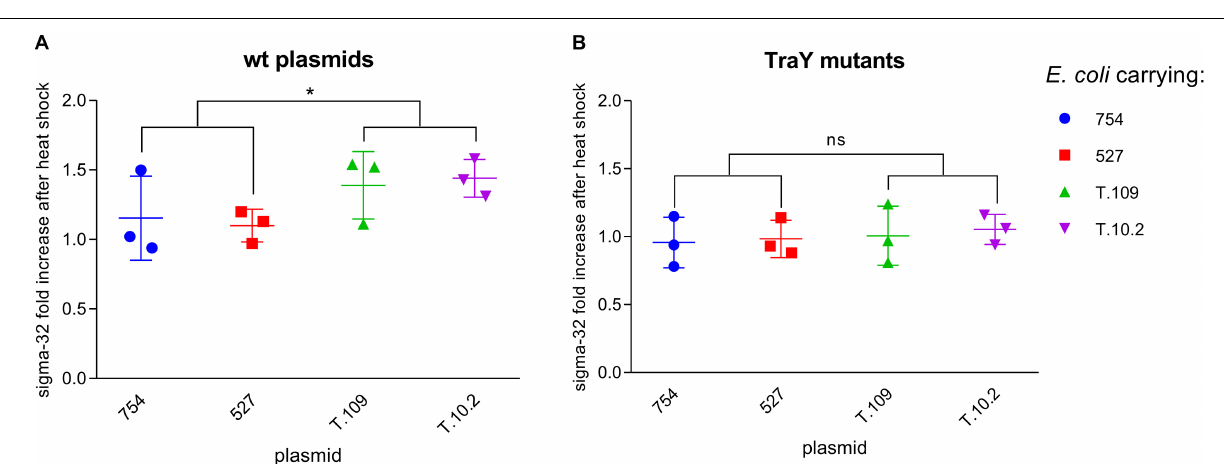
FIGURE 4 | (A) σ -32 fold increase between 37 and 42 ◦ C in Escherichia coli carrying wt plasmids. ∗ depict statistical significance ( p = 0.037). (B) σ -32 fold increase between 37 and 42 ◦ C in E. coli carrying plasmids with mutated TraY; Bars depict the mean and standard